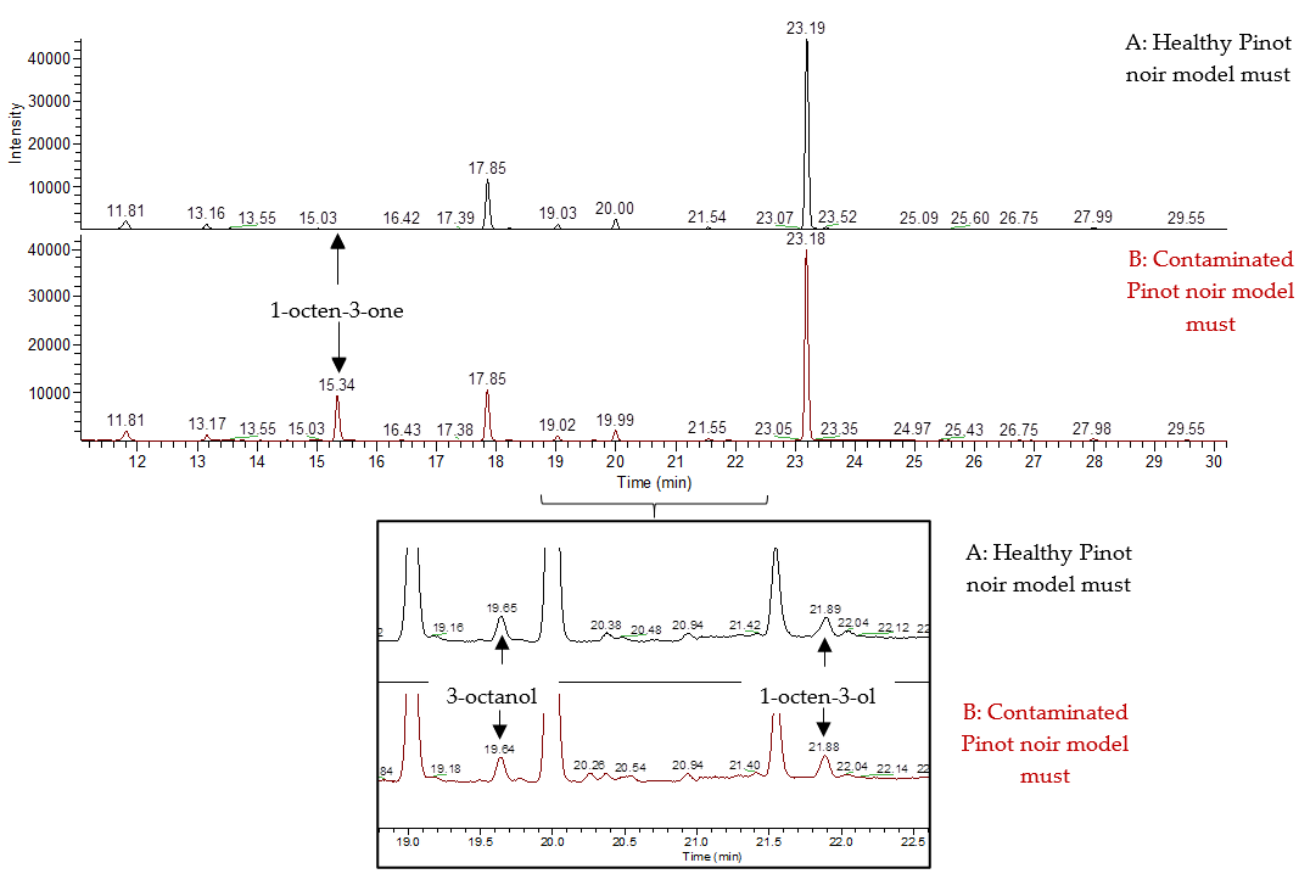
Figure 1 . Chromatogram of free C8 compounds of the (A) healthy and (B) contaminated Pinot noir model must .